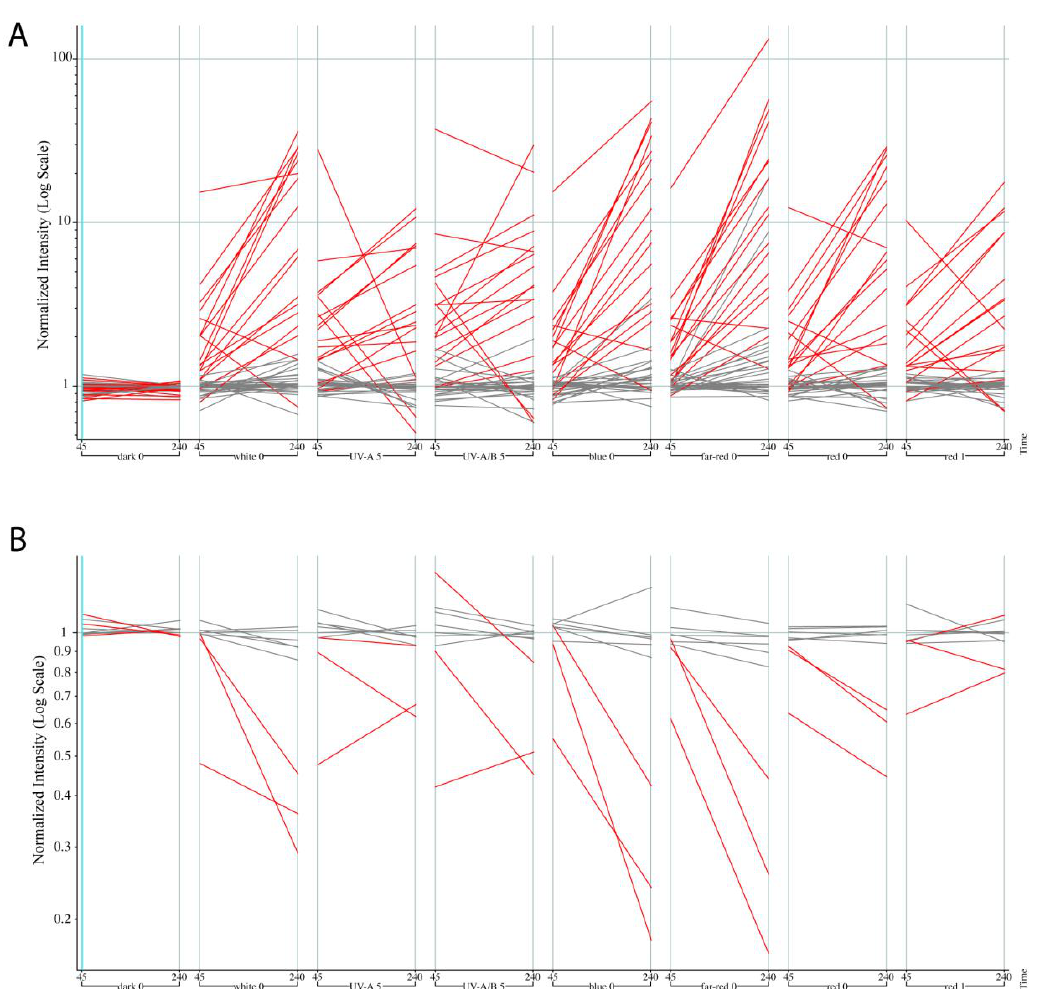
Figure 4. Regulation by light for LAR and DAR genes in the AtGenExpress: “Light Treatments” experiment. ( A ) The 46 out of 56 LAR genes found in the dataset, with seventeen two-fold up-regulated in white light, highlighted in red. ( B ) The 9 out of 11 DAR genes found in the dataset, with three two-fold down-regulated in white light, highlighted in red.